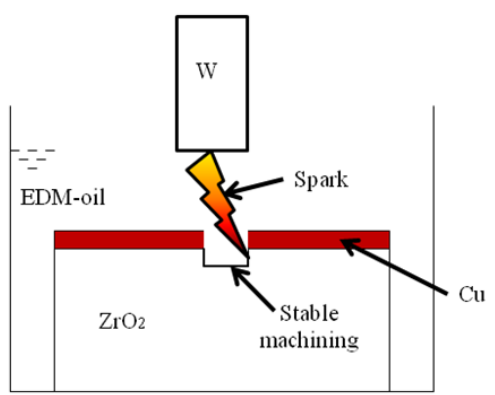
Figure 2: Schematic diagram of micro-EDM of non-conductive zirconia using adhesive copper assisting electrode